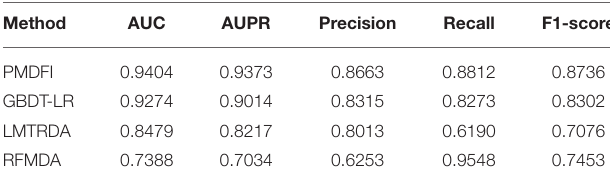
TABLE 2 | The comparison of different methods based on 5-fold